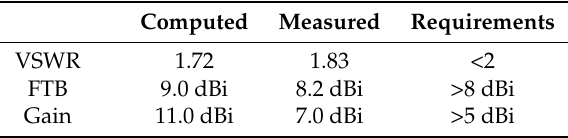
Table 2. Experimental assessment. Comparison between computed and measured antenna